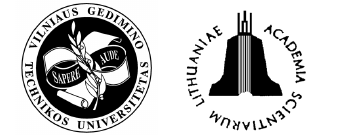
(Fig2). Analyzing the freight flows of the line-